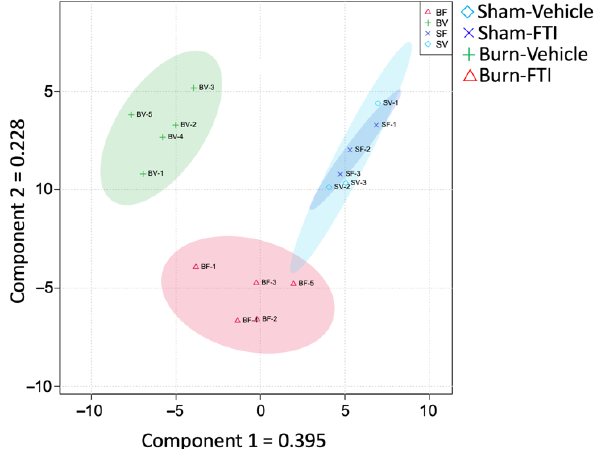
Figure 2. PLS-DA score scatter plot. Blue diamond: Sham-Vehicle, Blue cross mark: Sham-FTI, Green plus mark: Burn-Vehicle, Red triangle: Burn-FTI.